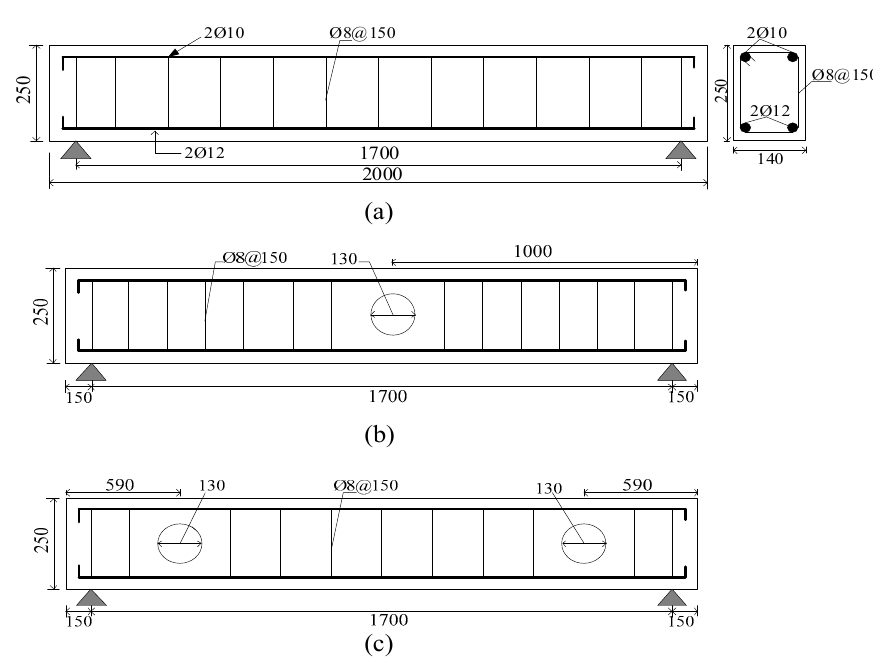
Figure 1. Details of un-strengthened beams (control beams): ( a ) beam dimension and section details, elevation of solid beam B-0, ( b ) elevation of BC-1, ( c ) elevation of BC-2. Note: all dimensions in mm.